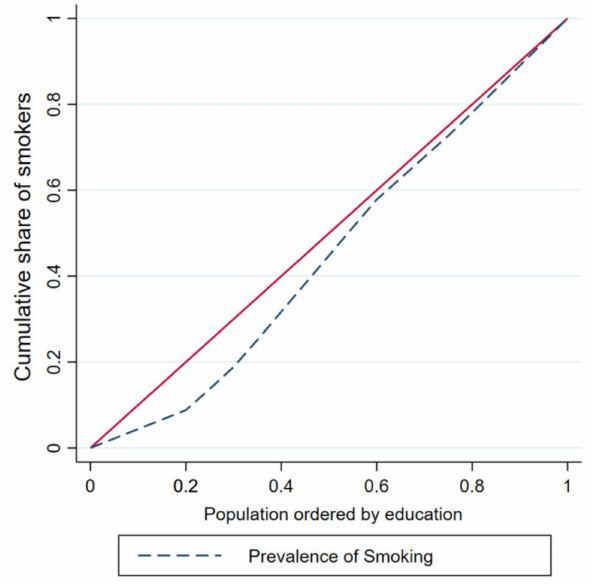
Figure 2. Education-based concentration